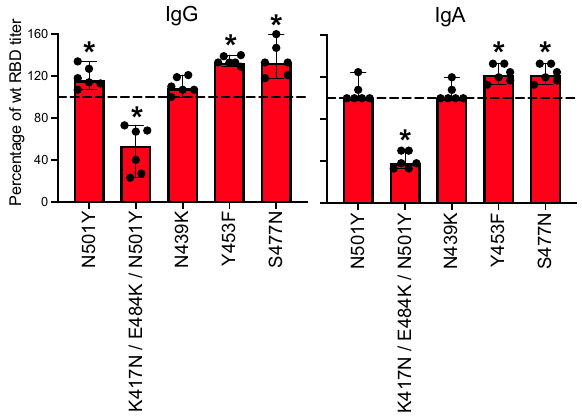
Fig. 3 Antibody responses against SARS-CoV-2 variants. We analyzed plasma samples from six patients with known antibody response against the native RBD protein for binding of their polyclonal IgG (left) and IgA (right) antibodies to RBD proteins harboring distinct mutations typically found in different SARS-CoV variants. Binding of polyclonal sera was signi fi cantly reduced compared to the wildtype RBD (dashed line) in the case of the RBD protein containing three different mutations K417N/ E484K/N501Y. Bar graphs indicate medians and whiskers indicate 95% C.I. Asterisks indicate signi fi cance levels of p < 0.05 when compared to responses against the native RBD protein in the same patient using a Wilcoxon test.